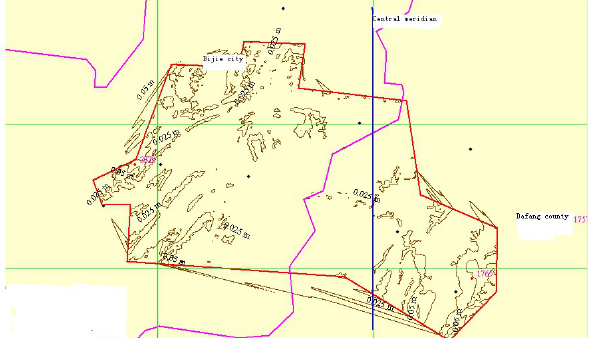
Fig. 1 Enlarged map of the length deformation exceeding the limit of Bijie central area independent coordinate